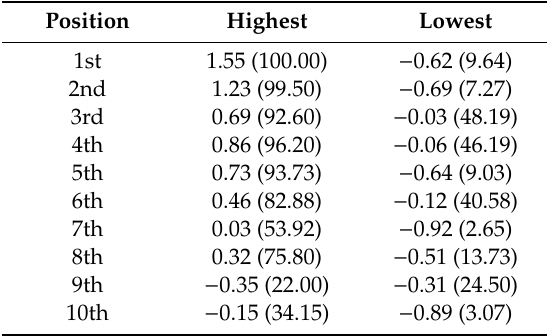
Table 2. Predicted breeding values and percentile within their ranking (between brackets) of the participants in the highest or lowest estimated